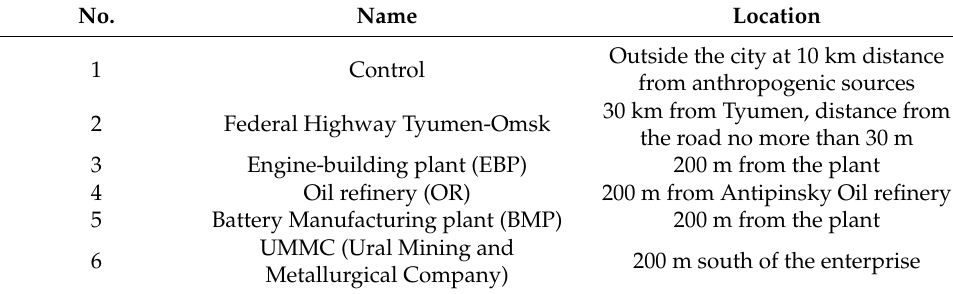
Table 1. Sampling